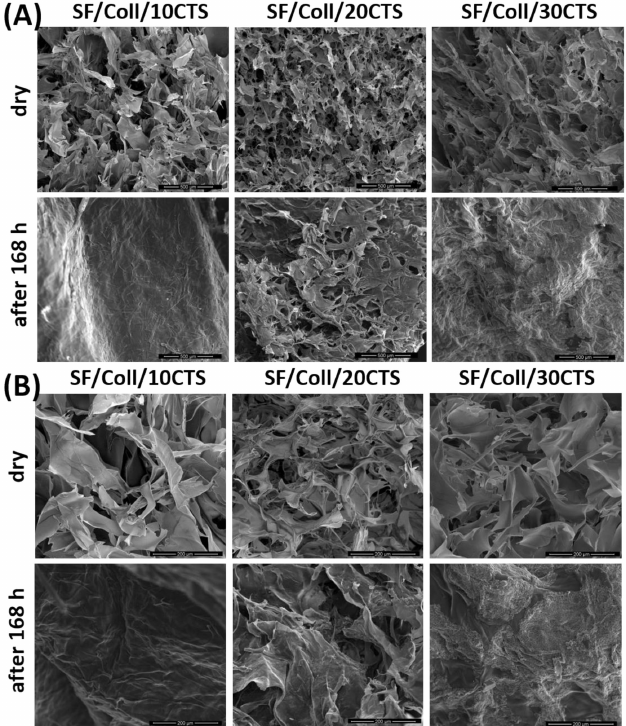
Figure 9. SEM images of SF/Coll mixtures with 10, 20 and 30% of CTS, cross-linked by EDC/NHS, for dry scaffolds and scaffolds after 168 h of immersion in PBS: ( A ) magnification 500 × ; ( B ) magnifi- cation 150 × .